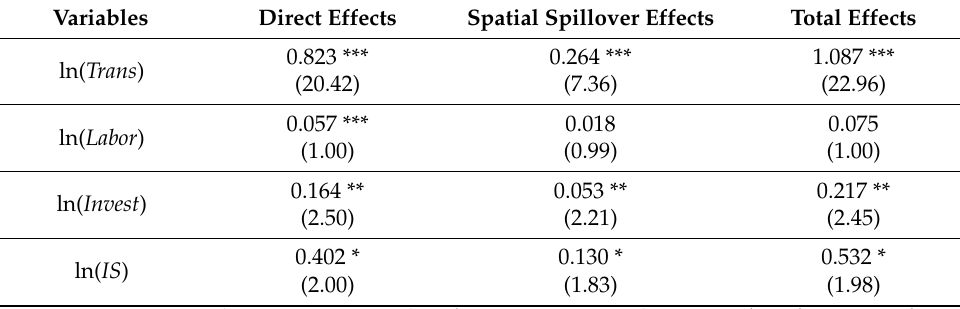
Table 5. Estimation results of the spatial Durbin